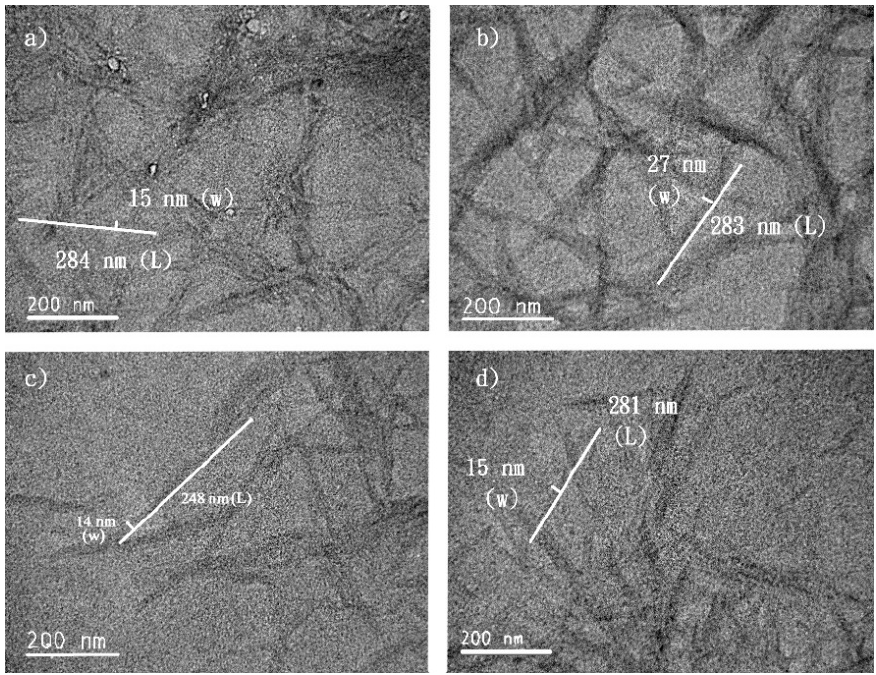
Figure 6. P-CNCs prepared with 63% sulfuric acid at 45 °C for ( a ) 0.5 h, ( b ) 1 h, and ( c ) 2 h and at 65 °C for ( d ) 2 h.